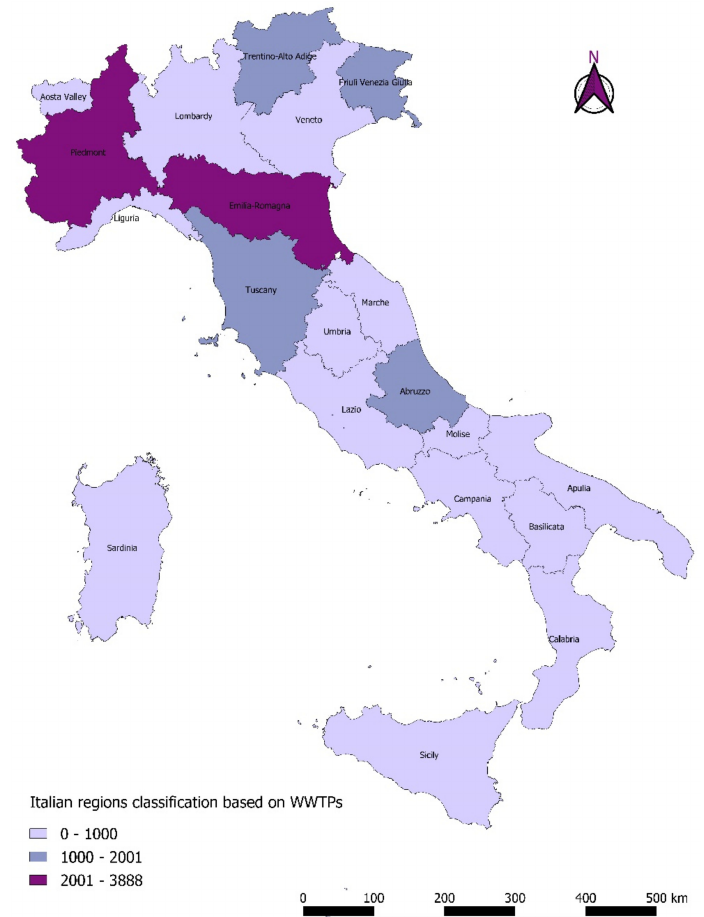
Figure 1. WWTP distribution at the territorial level within the Italian regions.